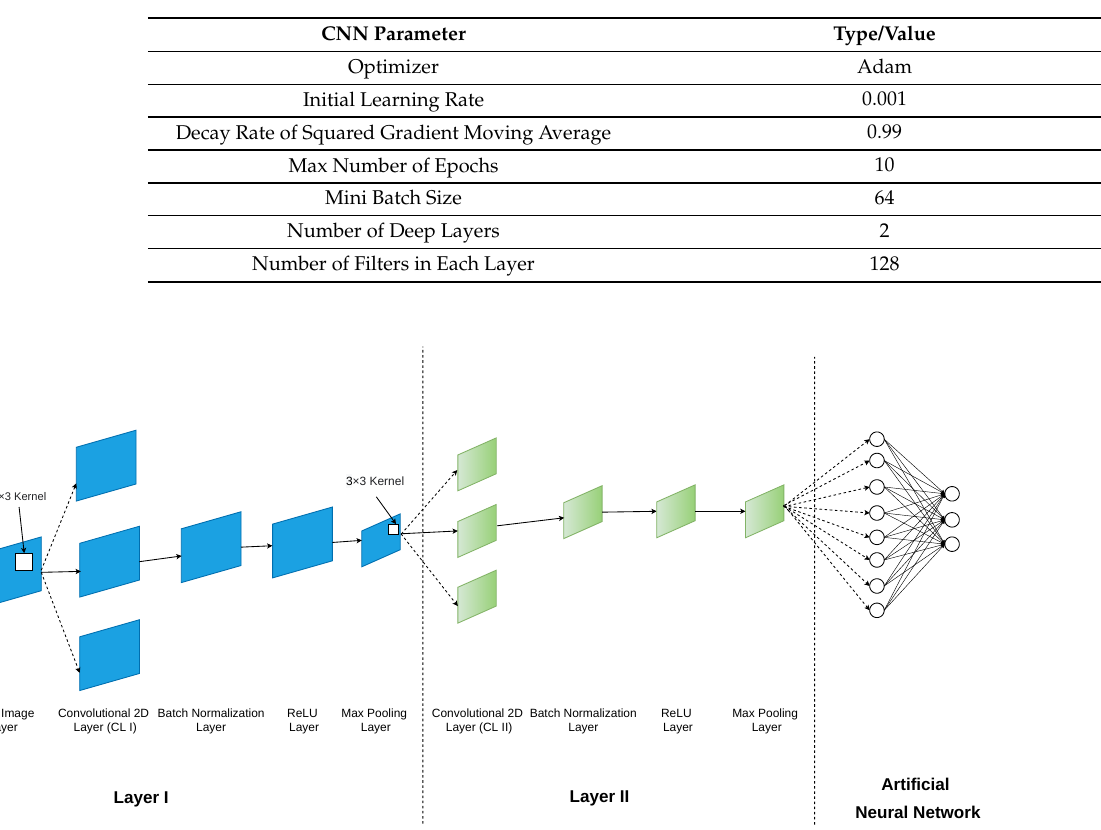
Figure 5. Designed convolutional neural network structure for the proposed